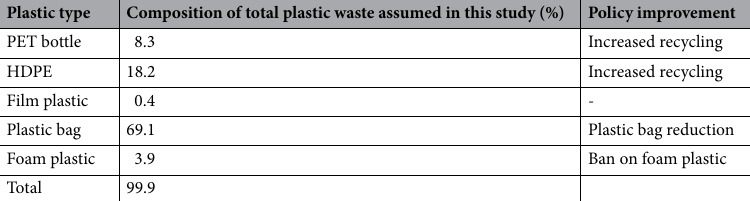
Table 1. Commercial solid waste generation in Phnom Penh 31 , used in this study to understand how policy changes may impact total plastic losses into